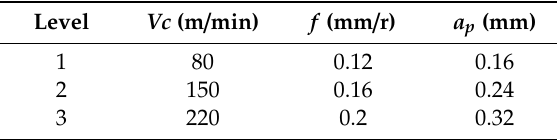
Table 2. Level design of the orthogonal test